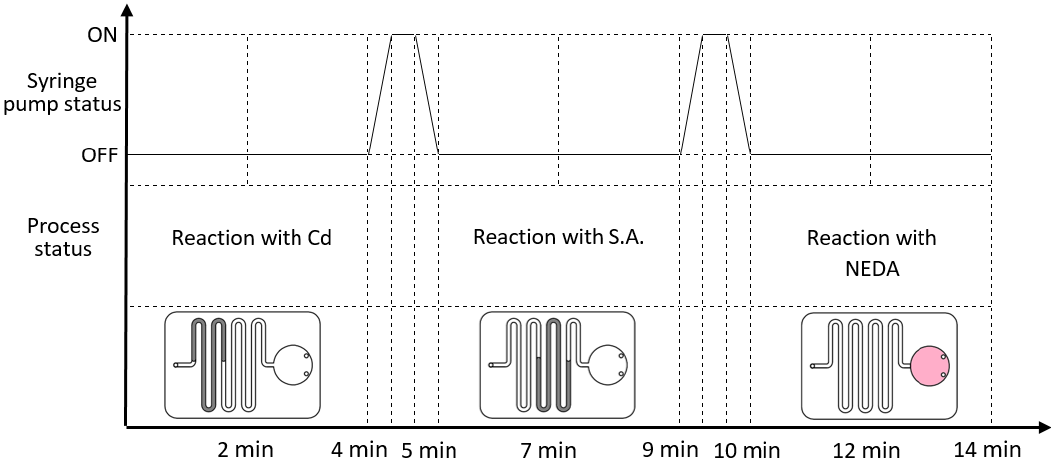
Figure 3. Experimental steps (top part) syringe pump status over time (bottom part) sample position inside the microfluidic chip over time.